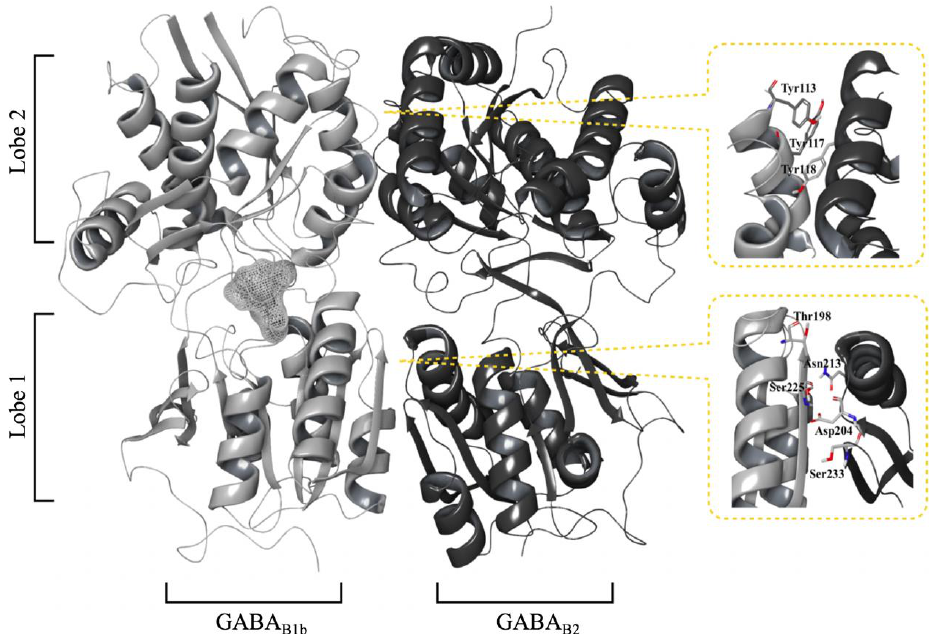
Figure 2. The heterodimeric extracellular GABA B1b receptor VFTs in the active state (PDB ID: 4MS4). Residues important for the Lobe 1-Lobe 1 and Lobe 2-Lobe 2 interactions are displayed in the yellow boxes. The approximate position of the binding pocket is displayed as a grey mesh in GABA B1 .